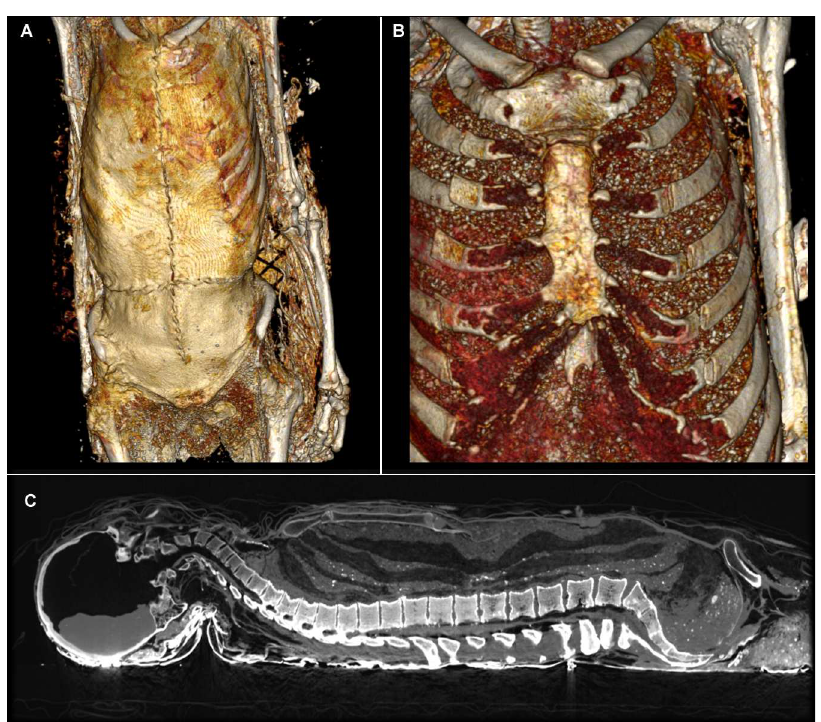
Fig 10. The Embalming of Louis Bruslon du Plessis. (A) The thorax was cut into with two large incisions in the shapeof a cross: one extendingfrom the suprasternalnotch to just abovethe navel, the other, perpendicular to the first, beneaththe chest, in front of the lower ribs. (B) The teguments were partially folded over to allow access to the ribs (3 to 7), which were then severed with clean, bilateralcuts. The sterno-costal cartilage at the lower end was also severed. (C) The breastplate was lifted, giving access to the thoracic organs, which were completelyremoved. Of the abdominalorgans, only the bladderremained in place. A dozenhorizontallayers of tow and vegetablepaddingwere inserted into the whole of the emptied cavities. Once the embalmingprocess was finished, the breastplatewas repositioned, the soft tissues put back in, and the abdominal-thoracicincision closed with thirty